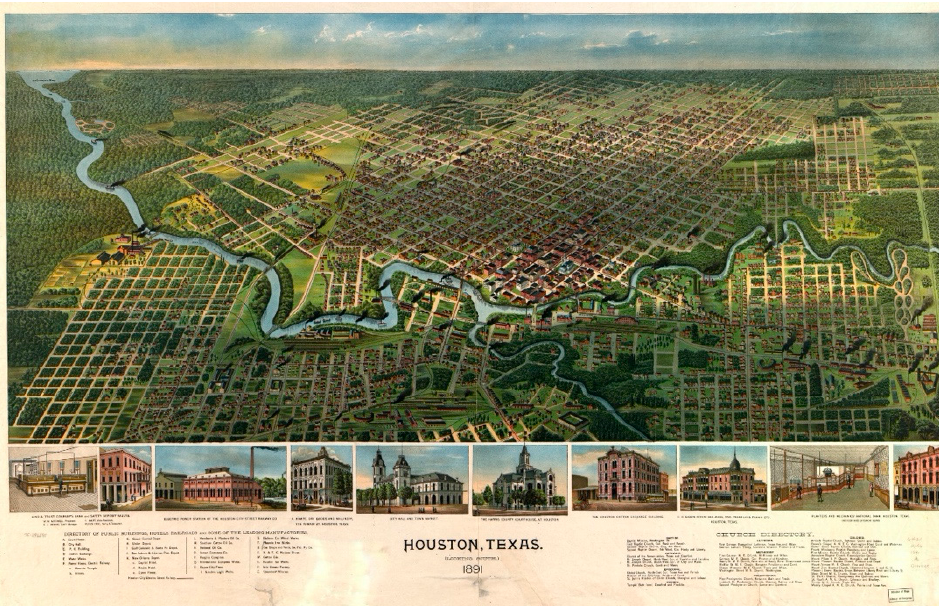
Figure 4. A map of Houston, Texas from 1891, courtesy of the Library of Congress. Despite high elevation (in Fifth Ward, 43 feet above sea level), Houston’s topography is flat. On this map, you can see Galveston Bay and Buffalo Bayou and White Oak Bayou flowed through the city. They continue to articulate the borders of neighborhoods. Some streets are paved with the familiar concrete, with street drainage ditches to prevent excessive rainwater from entering homes and flooding roads. The depth of the ditches and the large pipes fascinated me as a child. A group of ministers raised money through their churches to buy a 10-acre lot of land in Third Ward, which they named Emancipation Park (Hardy 2015). Black representatives were elected to the city council. By the early 1890s, 100,000 African Americans voted in Texas elections (Foner 1988). See Figure 5.